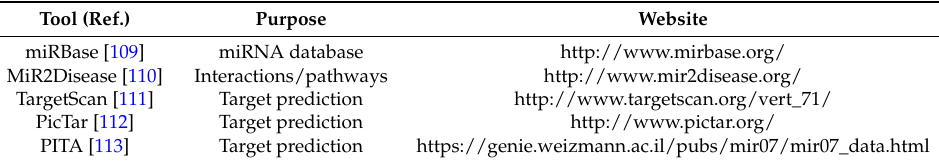
Table 4. Databases and software packages for miRNA